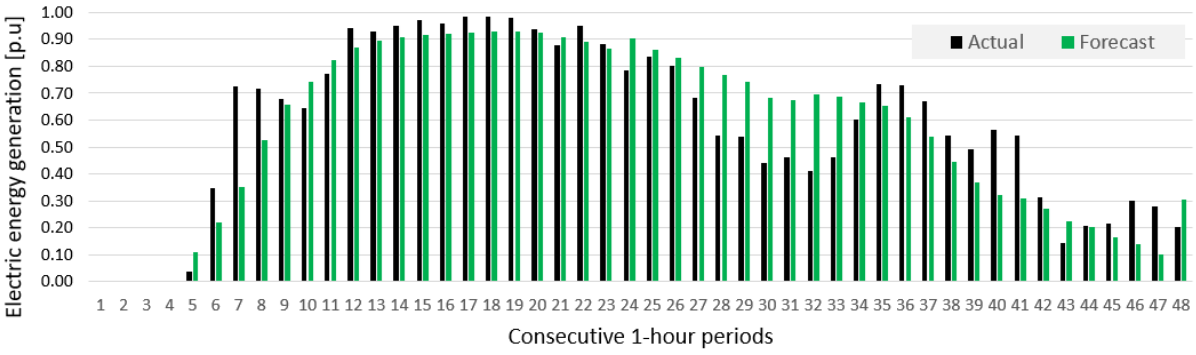
Figure 21. Two forecasts of electric energy generation for Wind Farm B made by INT_OUT_EXT [GBT, RF, PHYS(v1&v2) → KNNR, MLP, LSTM] method with additional expert correction for two consecutive days of an autumn month (November).